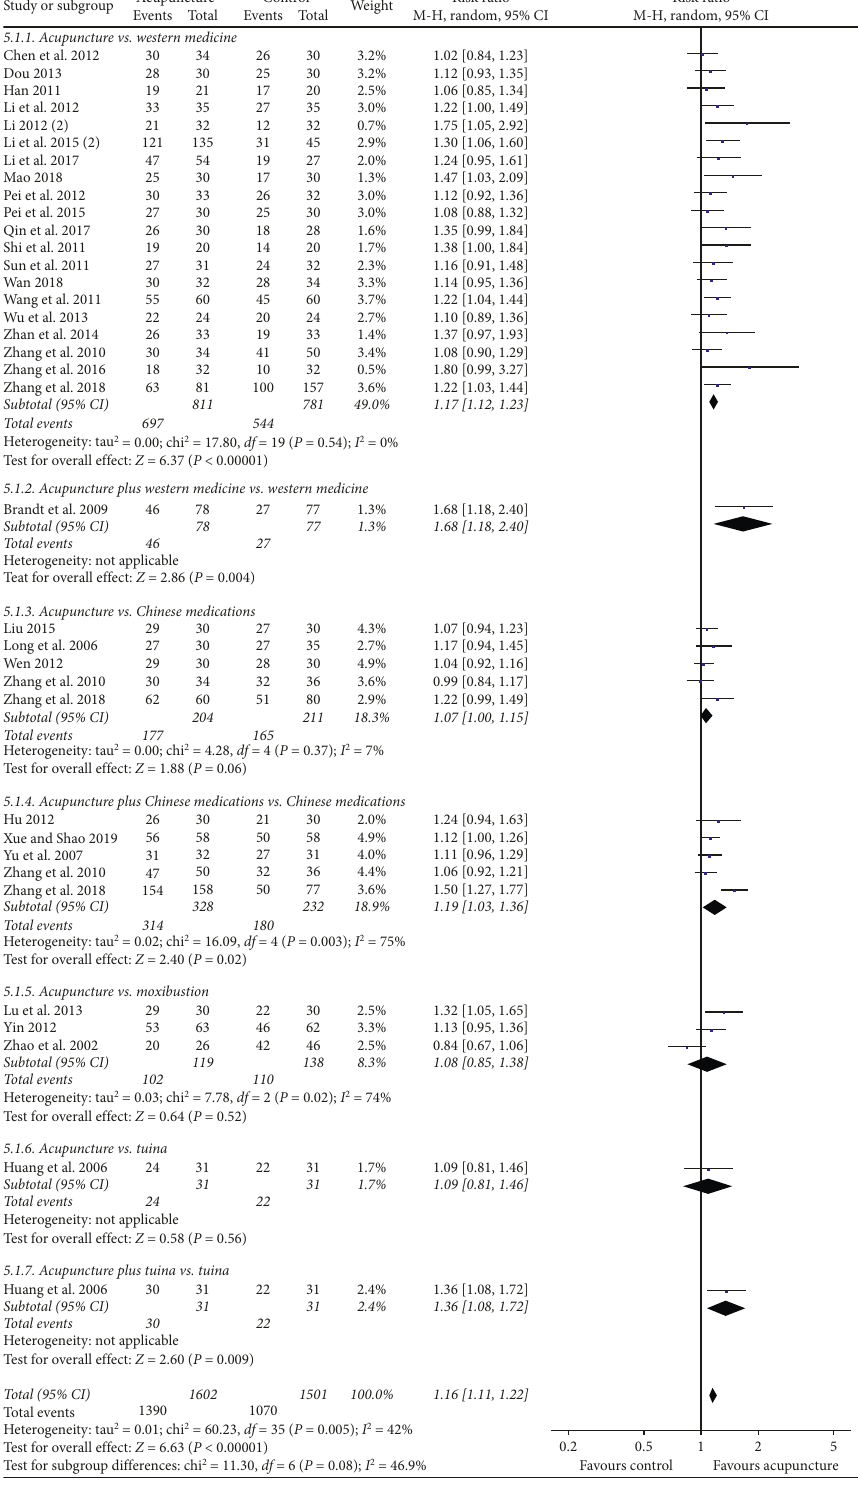
Figure 3: Forest plots for efficacy rates of acupuncture versus nonsham controls at the end of